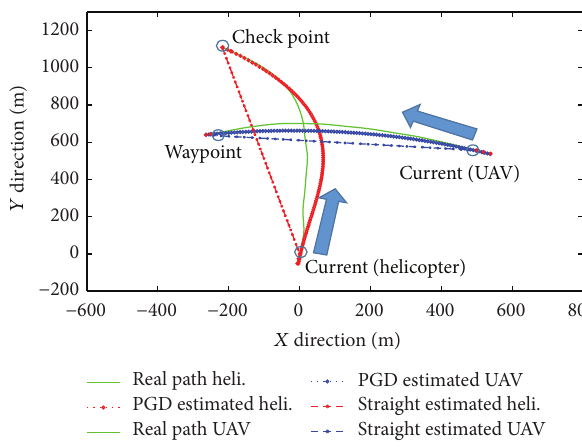
Figure 8: Test trajectory.